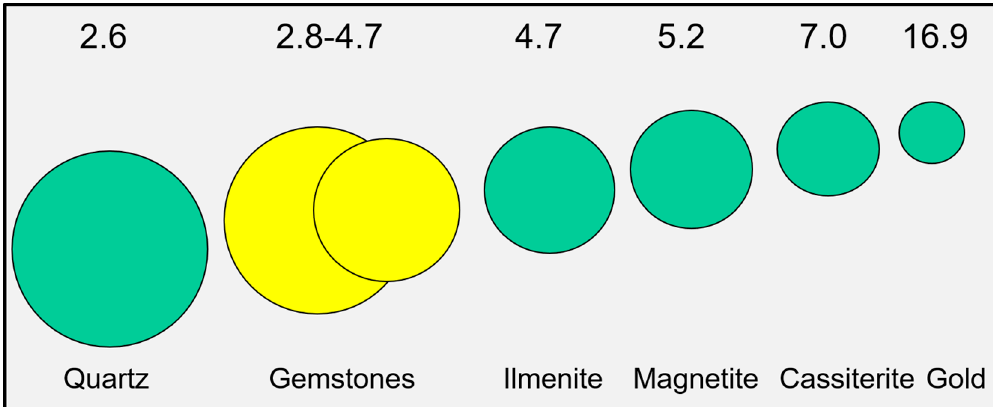
Figure 7. Hydraulic equivalence of heavy minerals relative to quartz (source of data, excluding those of gemstones from Reid and Frostick 1985) [42] with an amendment by the author with regard to gemstones.